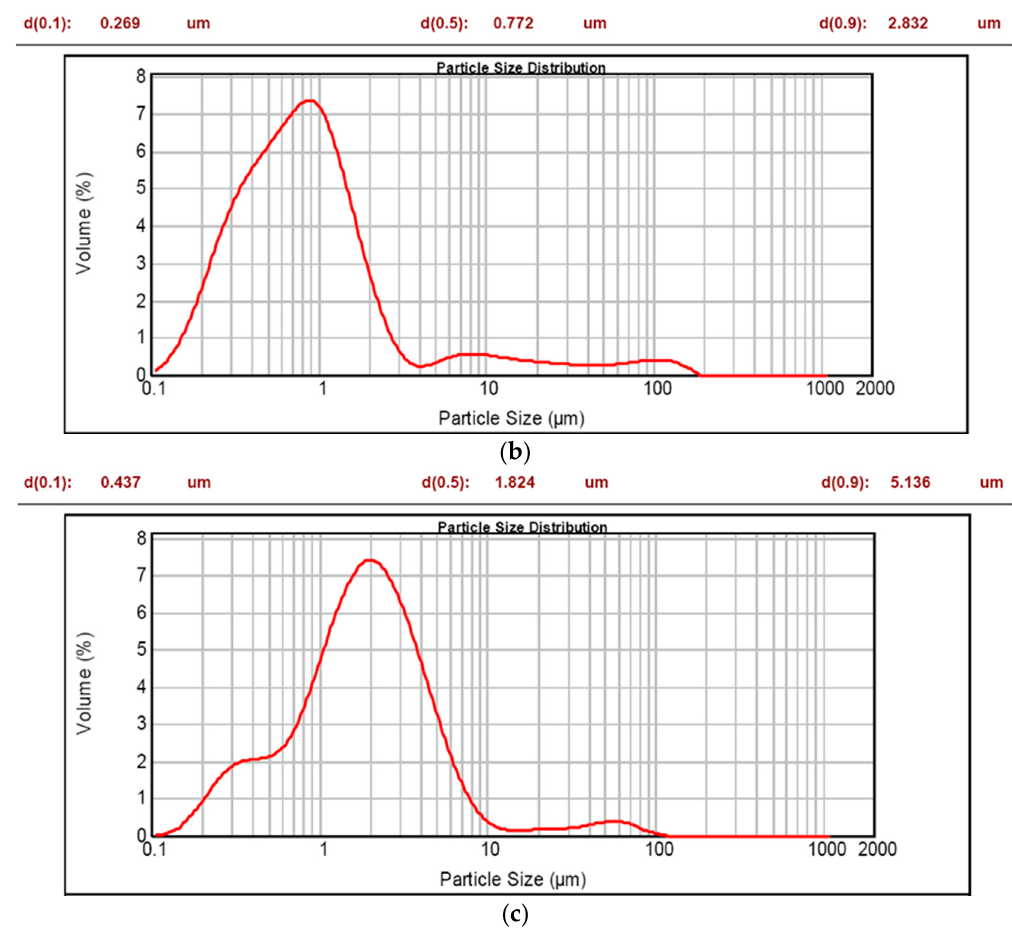
Figure 7. Particle size distribution for a 70 wt. % B15/25 for ( a ) d(0.5) s , ( b ) d(0.5) l , and ( c ) bimodal emulsion.